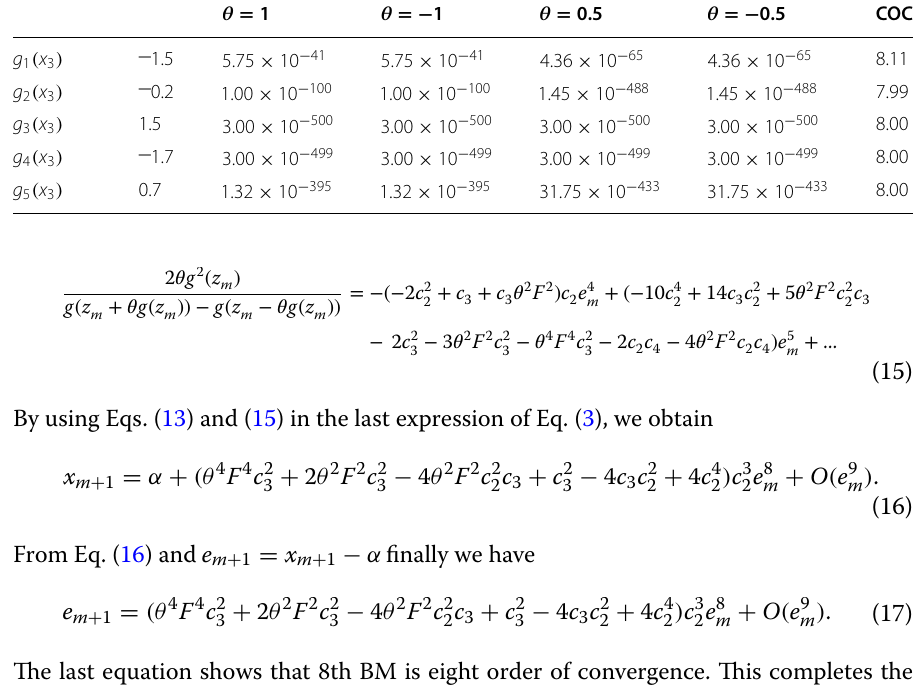
Table 1 Numerical results for test functions